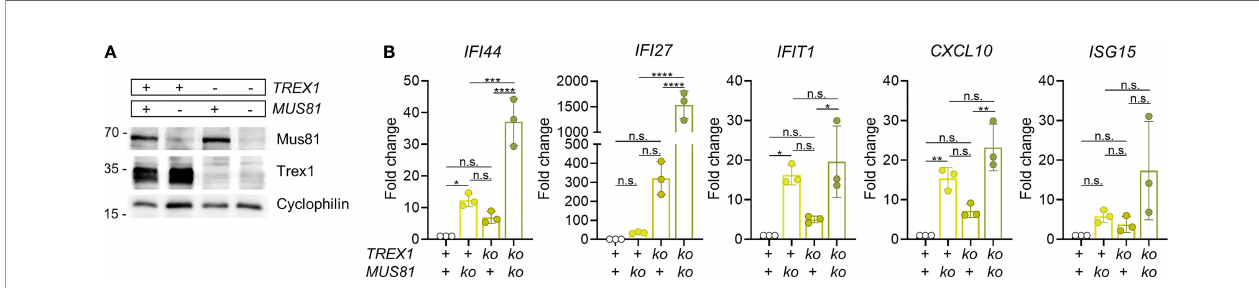
FIGURE 3 | Simultaneous inactivation of Trex1 and of Mus81 result in synergistically enhanced IFN response. (A) Western blot analysis of MUS81 expression by polyclonal cultures resulting from lentiviral transduction of control or Trex1 -/- THP1 cells (see Figure S3 ) with lentiCRISPR v2 plasmid encoding Mus81 -speci fi c guide RNA (TCTGAAATACGAAGCGCGTG) and selection for the presence of the plasmid. (B) ISG transcript levels in THP1 cells of the indicated genotypes quanti fi ed by qRT-PCR. Fold change compared with mean of WT controls is shown. Graph summarizes 3 independent experiments. ****p < 0.0001, ***p < 0.001, **p < 0.01, *p < 0.05, n.s., not signi